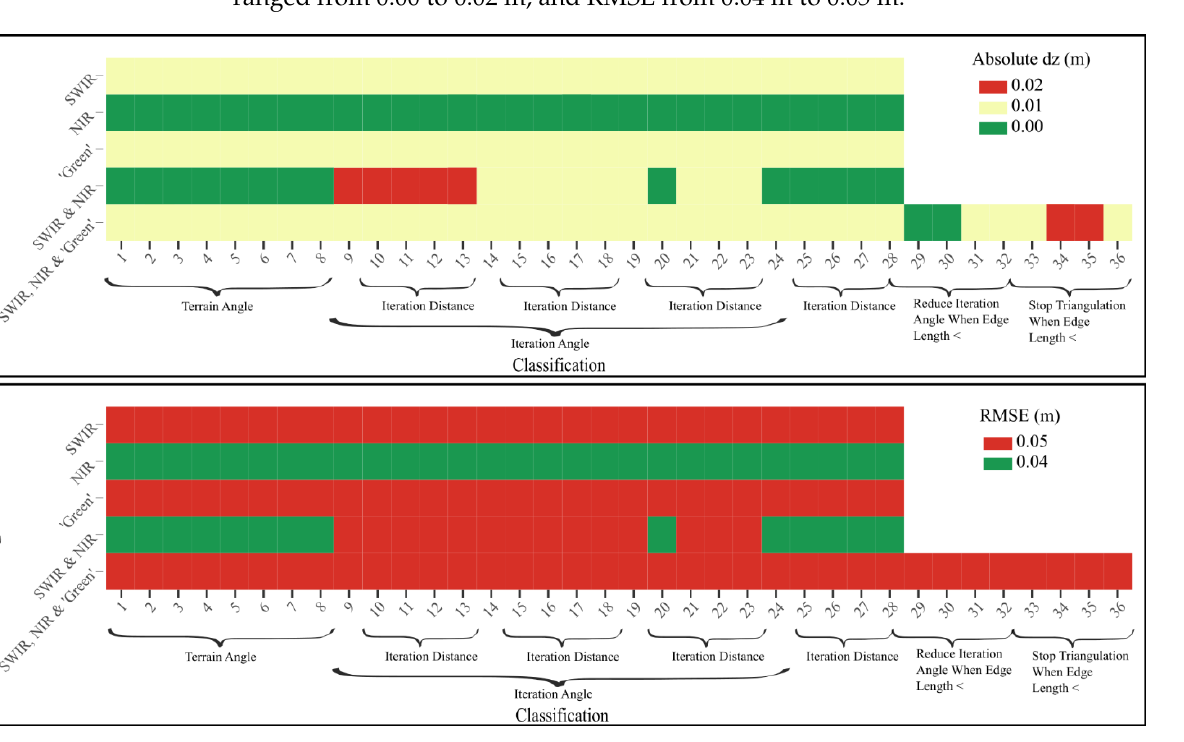
Figure 5 . Ground classification results (| 𝑑𝑧̅̅̅ | and RMSE) along a flat road surface for baseline com- parisons using parameterization methods in Table 2. Classifications were conducted in LAStools.